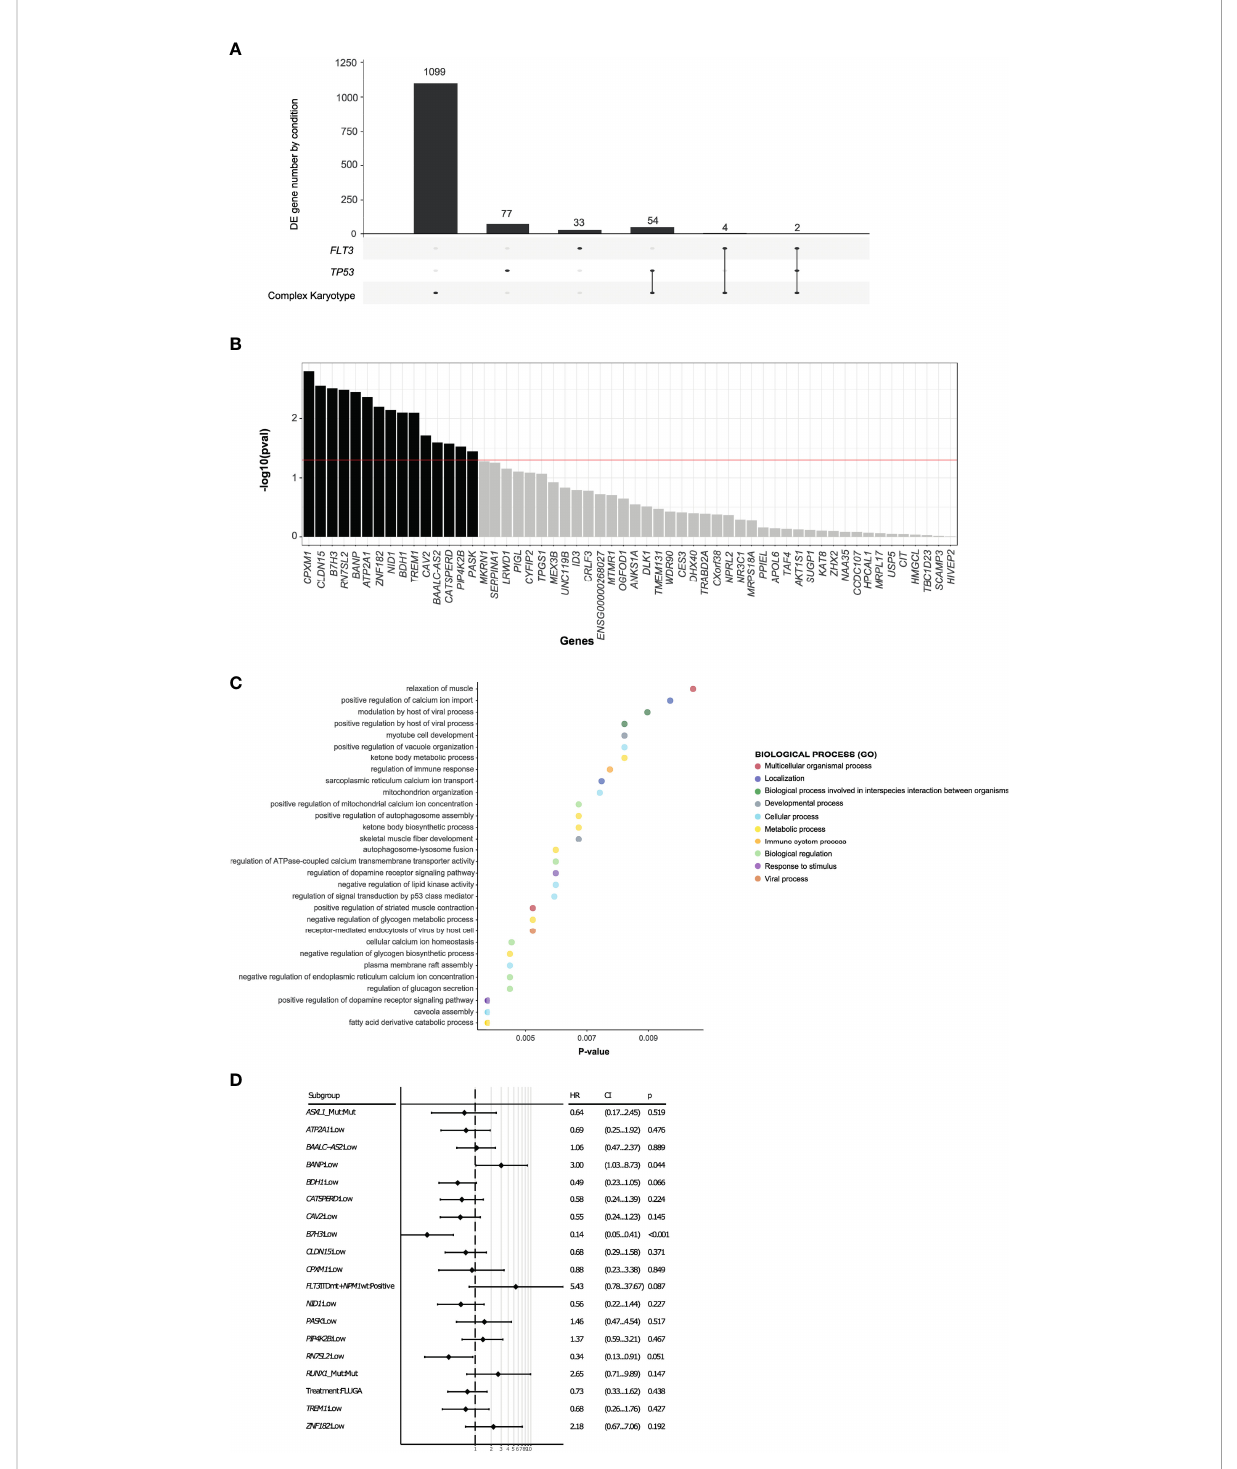
FIGURE 3 Expression of B7H3 and BANP genes are associated with overall survival of AML patients. (A) Differentially expressed genes between long-term survivors in the complex karyotype, TP53 mutated and FLT 3-ITD groups. (B) 15 differentially expressed genes shared by TP53 mutated and complex karyotype long survival AML patients with impact on the univariate survival analysis. (C) GO study of the 15 differentially expressed genes in long survival AML patients with TP53 mutated or complex karyotype, with impact on the univariate survival analysis. (D) Multivariate analysis including differentially expressed 15 genes and ELN adverse category mutations such as RUNX1 , ASXL1, FLT3-ITD with NPM1 wt